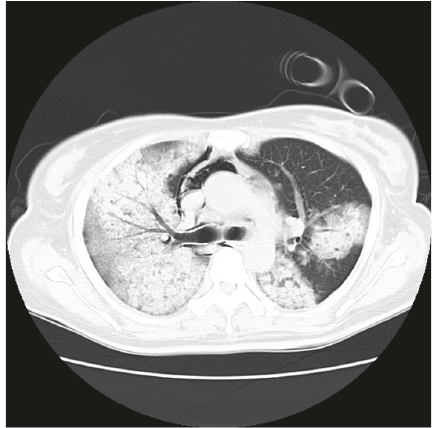
Figure 2: CT scan upon the start of high-dose corticosteroid therapy. The scan shows bilateral pulmonary infiltrates along the peripheral bronchovascular bundles and ground-glass opacities with a panlobular distribution.